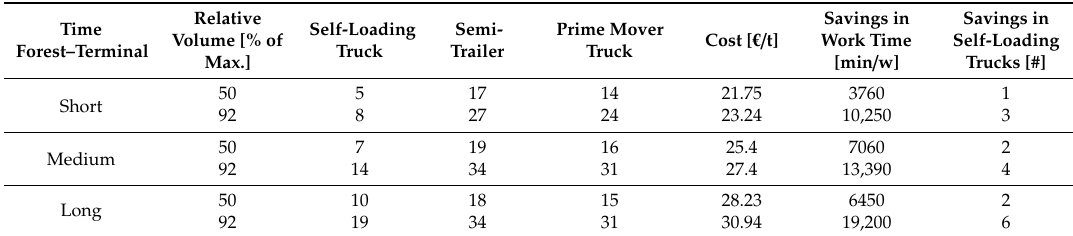
Table 6. Cost-optimal fleet configuration with self-loading truck gross vehicle weight of 50 t and savings by increasing the legal gross vehicle weight for timber transport from 44 to 50